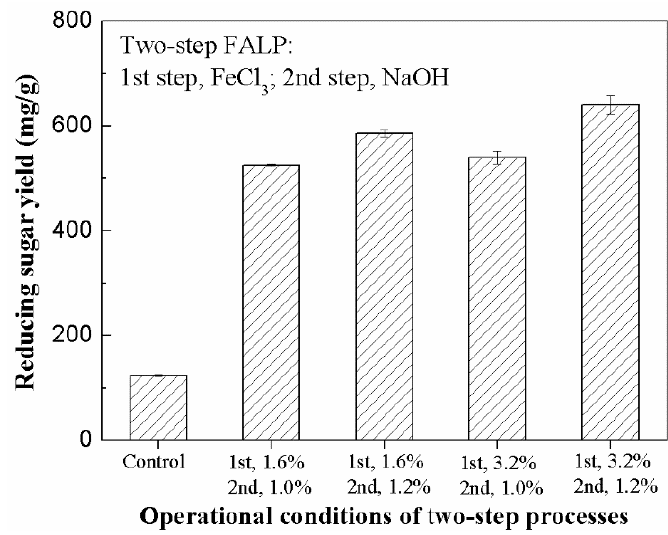
Figure 3. E ff ect of two-step ferric chloride-alkaline pretreatment (FALP) on enzymatic hydrolysis (Note: Figure 3. Effect of two ‐ step ferric chloride ‐ alkaline pretreatment (FALP) on enzymatic hydrolysis The levels of reducing sugars were determined by DNS (Note: The levels of reducing sugars were determined by DNS assay ) .